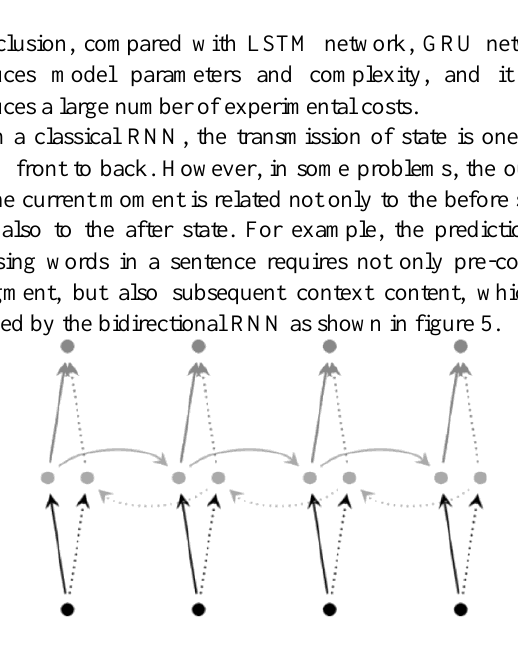
Bidirectional RNN is combined two single RNNs. At each time, two RNNs in opposite directions are input at the same time. They determine the output together to make the result more accurate. The RNN in the bidirectional RNN is replaced with GRU structure to form Bi-GRU.